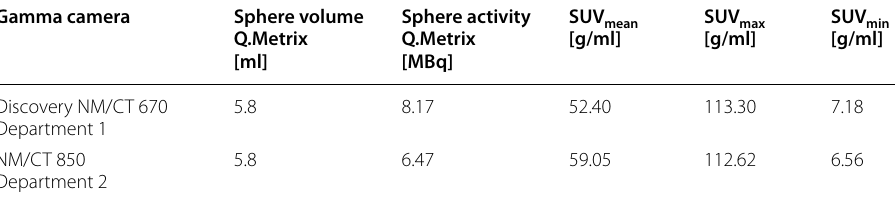
Table 3 SUVmax and SUVmean for φ 22‑mm sphere obtained using two gamma cameras: Discovery NM/CT 670 and NM/CT 850, in the two medical departments. The radioactive decay corrections were included in the